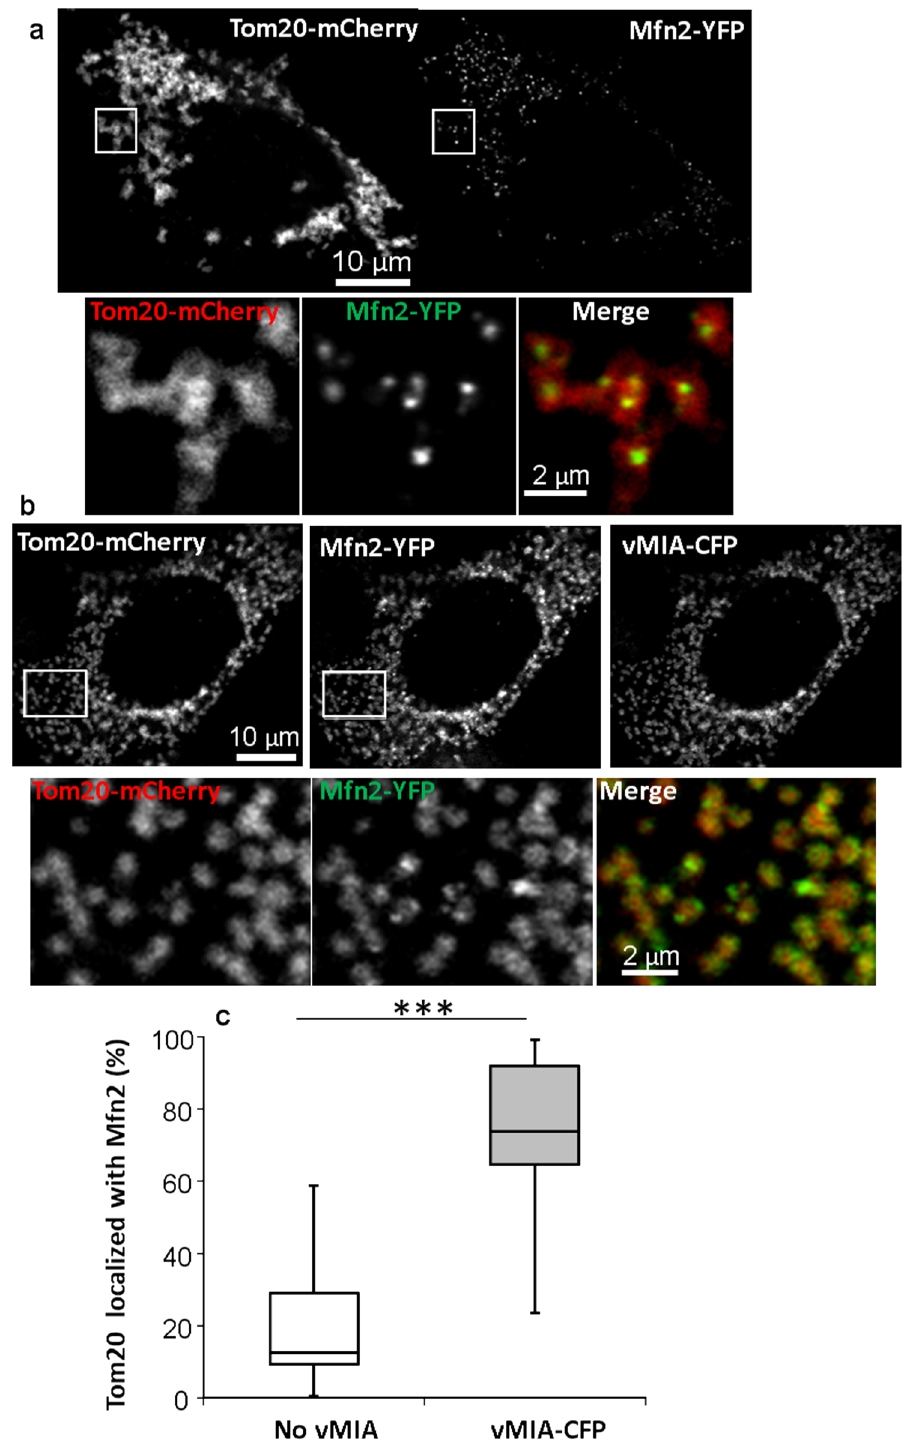
Figure 3. Expression of vMIA causes redistribution of Mfn2 on the OMM. MEFs transfected with Mfn2-YFP (pseudocolored green) and Tom20-mCherry (red), ( a ) without or ( b ) with vMIA-CFP (blue) were analyzed by confocal microscopy. ( a ) In MEFs not expressing vMIA, Mfn2 shows punctate distribution along the mitochondria; boxes mark the zoomed regions shown below. ( b ) Expression of vMIA causes Mfn2 to distribute more uniformly along the mitochondria; boxes mark the zoomed regions below. ( c ) Plot showing quantification of Mfn2 colocalization with OMM marker Tom20 in MEFs expressing or not expressing vMIA-CFP. The line in the box represents the median value of cells not expressing (13%) or expressing vMIA (73.9%) (n > 16 cells). *** Represents p <